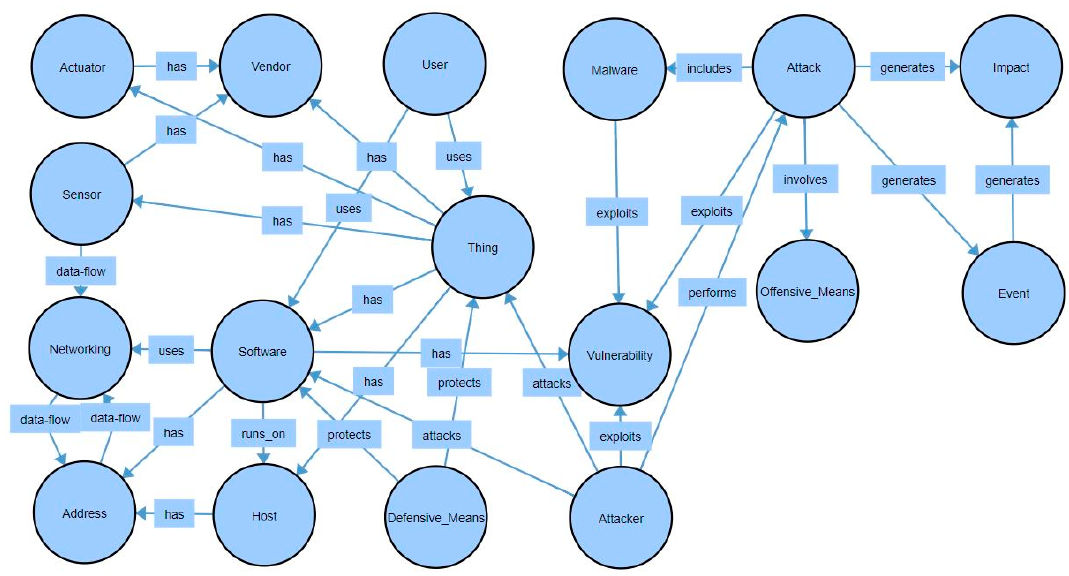
Figure 3. The structure of the ontology used for NER (classes and relations).